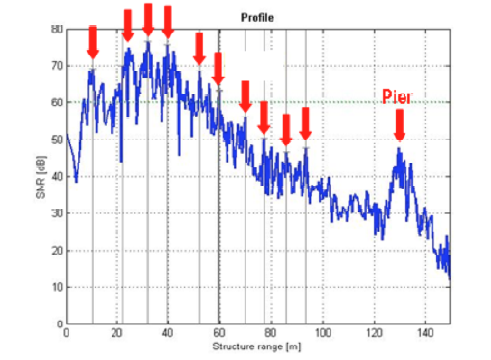
Figure 4. Range profile of the received radar signal. Red arrows mark the peaks corresponding to the bridge gilders